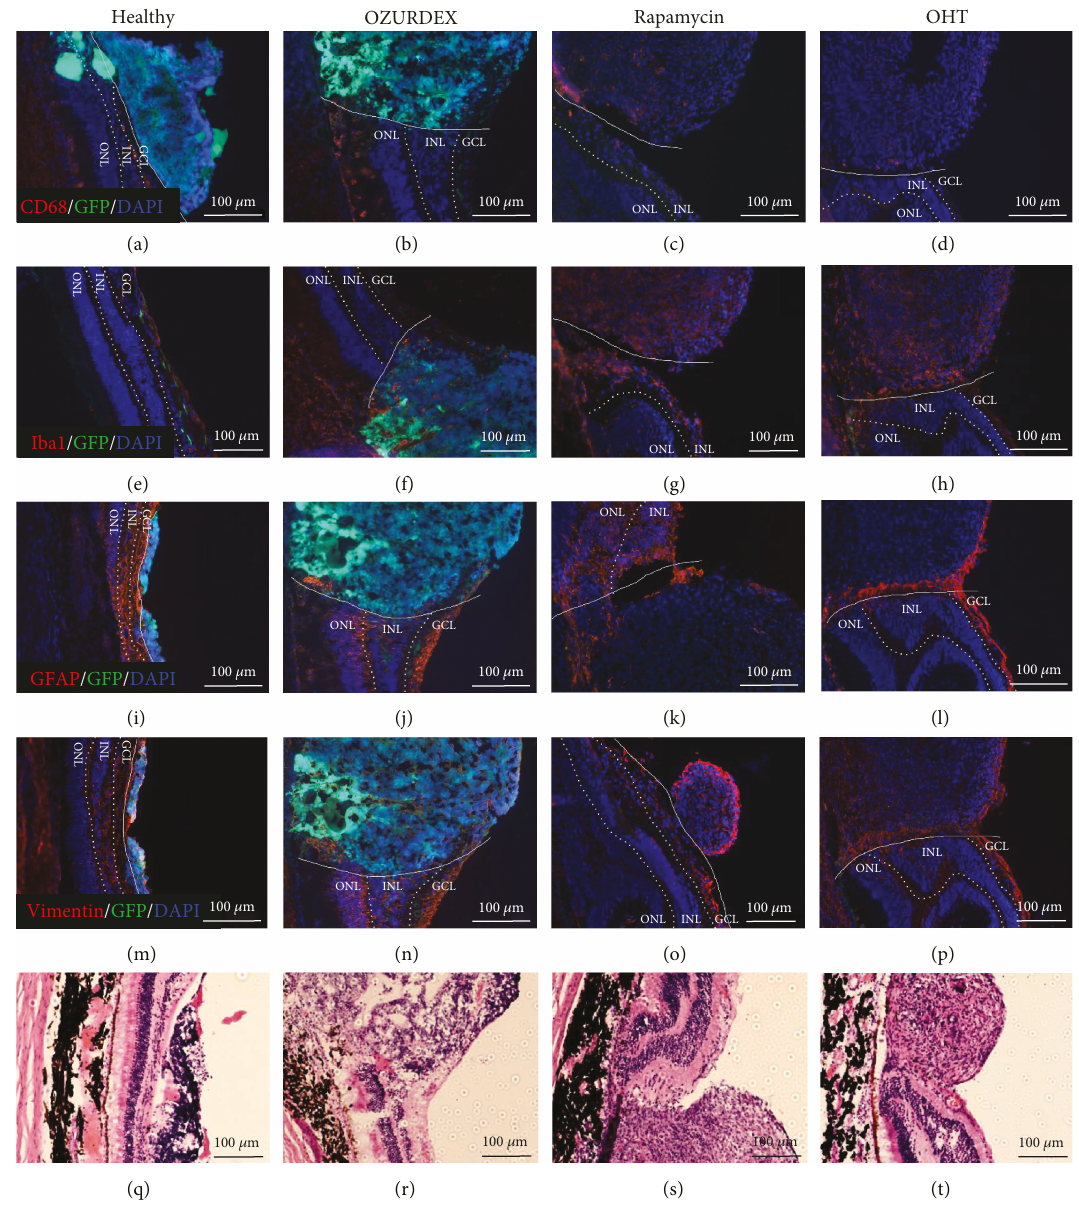
Vimentin/GFP/DAPIGFAP/GFP/DAPIIba1/GFP/DAPICD68/GFP/DAPI Figure 7: Immune responses after transplantation. (a, b, d) Few activated microglia (CD68-positive) were seen in the healthy eye (transplanted with a retinal organoid, but receiving no immunosuppressive treatment), Oz-eye (eye with ocular hypertension (OHT) transplanted with a retinal organoid and treated with dexamethasone), and OHT-eye (OHT eye transplanted with a retinal organoid, but receiving no immunosuppressive treatment). (c) However, many CD68-positive cells were seen in the RAP-eye (OHT eye transplanted with a retinal organoid and treated with rapamycin). (e) In the healthy eye, few microglia (Iba1-positive) were spread out within the inner retina. (f) Few microglia (Iba1-positive) were seen clustered near the transplant site in the Oz-eye. In the (g) RAP-eye and the (h) OHT- eye, large numbers of microglia (Iba1-positive) were found to be accumulated at the transplant sites. (i) GFAP- and (m) vimentin-positive Müller cells were distributed throughout the inner retina of the healthy eye. Similarly, (j) GFAP- and (n) vimentin-positive Müller cells were distributed throughout the inner retina of the Oz-eye. However, in the RAP-eye, (k) GFAP- and (o) vimentin-positive Müller cells were found surrounding the transplantation site. Similarly, in the OHT-eye, (l) GFAP- and (p) vimentin-positive Müller cells were found to surround the transplantation site. HE staining showed that in the (q) healthy eye and the (r) Oz-eye, the transplantation site had rosette-forming cell clusters with high nuclear-cytoplasmic ratios. In the (s) RAP-eye and the (t) OHT-eye, however, weakly basophilic cells were found to accumulate at the transplantation site. No obvious lymphocytes were detected around the transplantation site in four groups. GCL: ganglion cell layer; INL: inner nuclear layer; ONL: outer nuclear